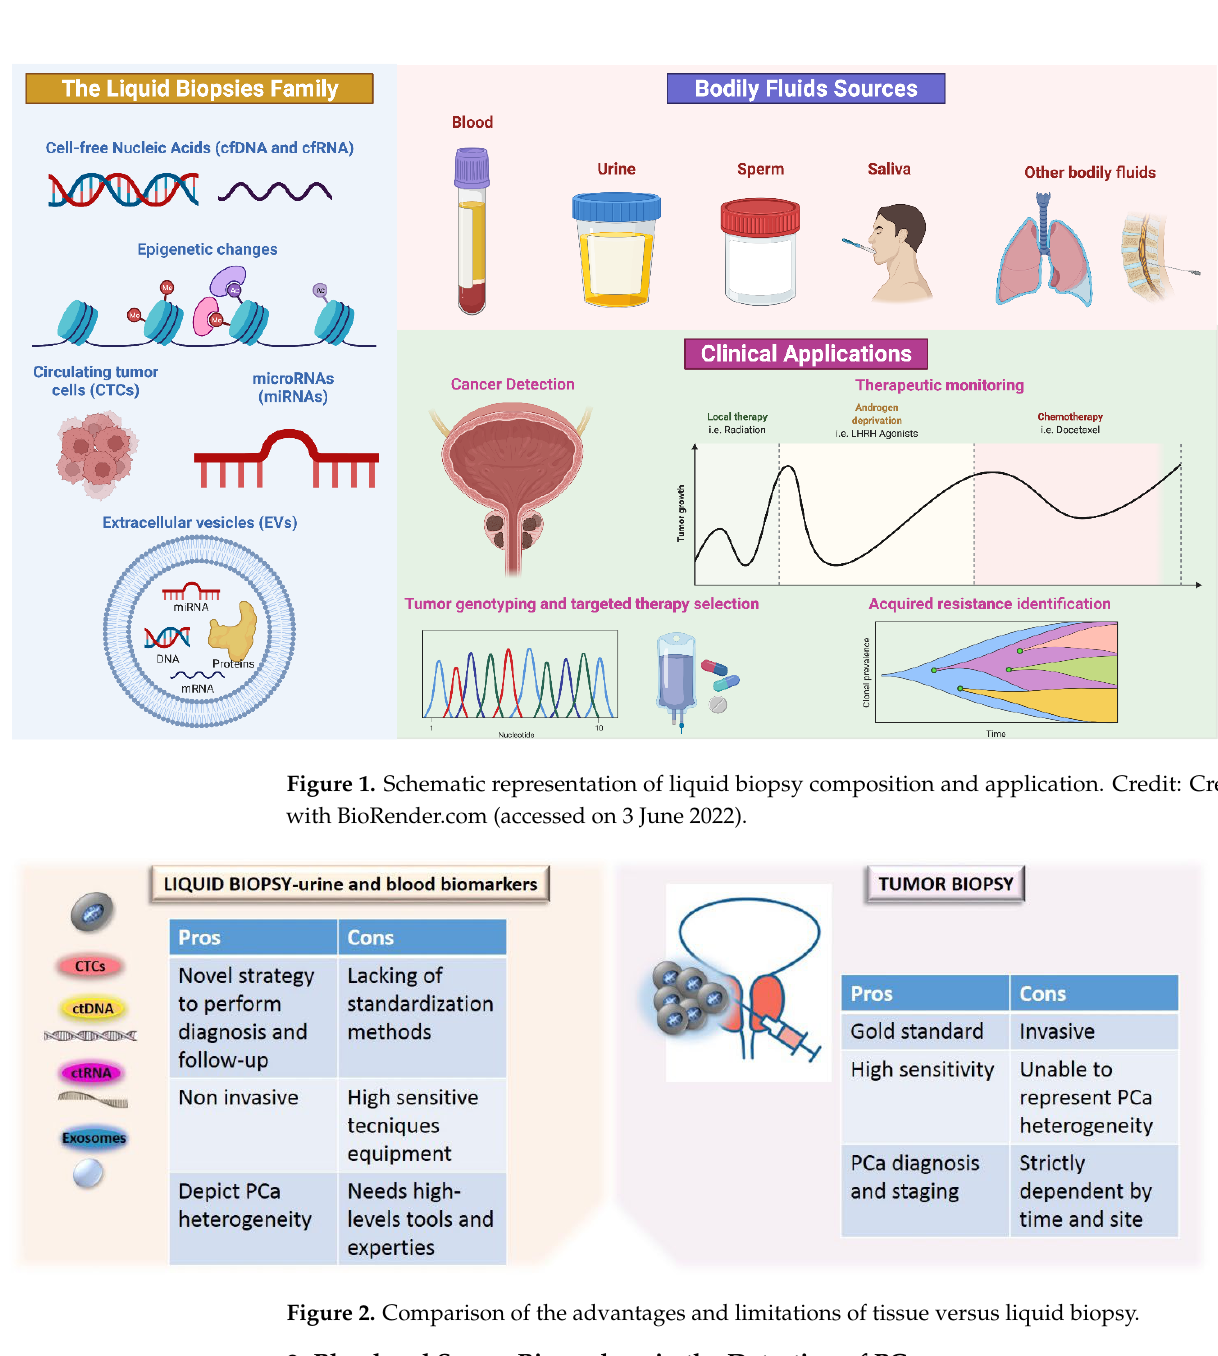
Figure 2. Comparison of the advantages and limitations of tissue versus liquid biopsy.